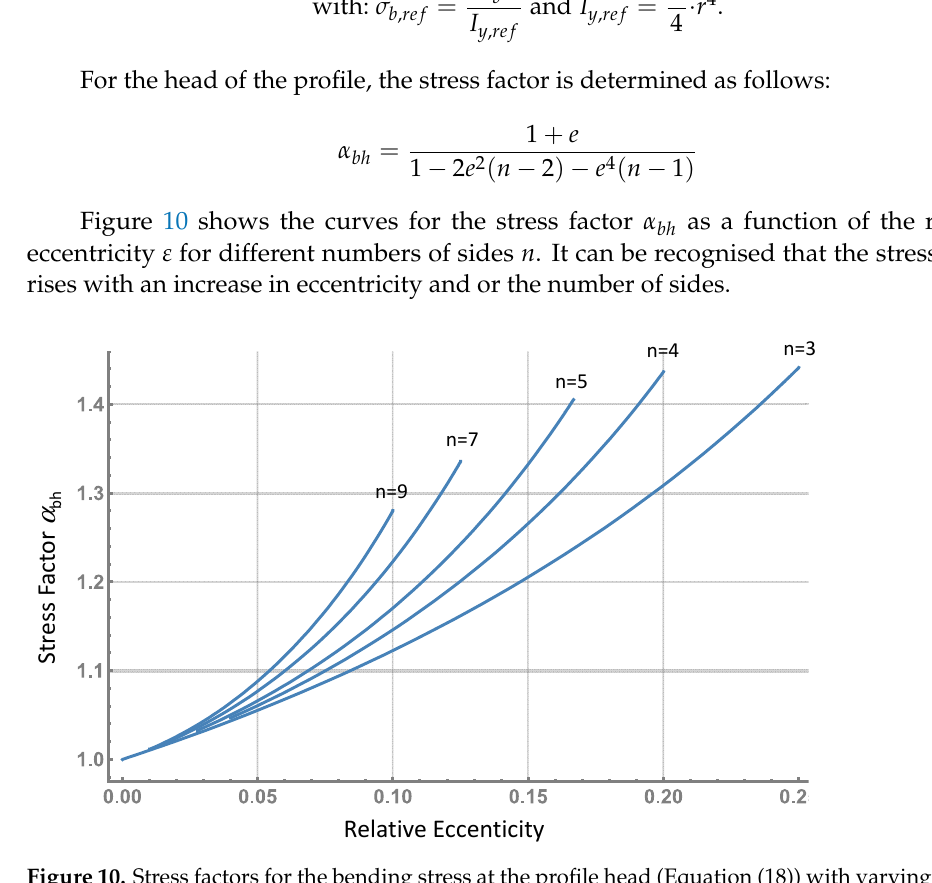
Figure 10. Stress factors for the bending stress at the profile head (Equation (18)) with varying relative eccentricity and number of sides.